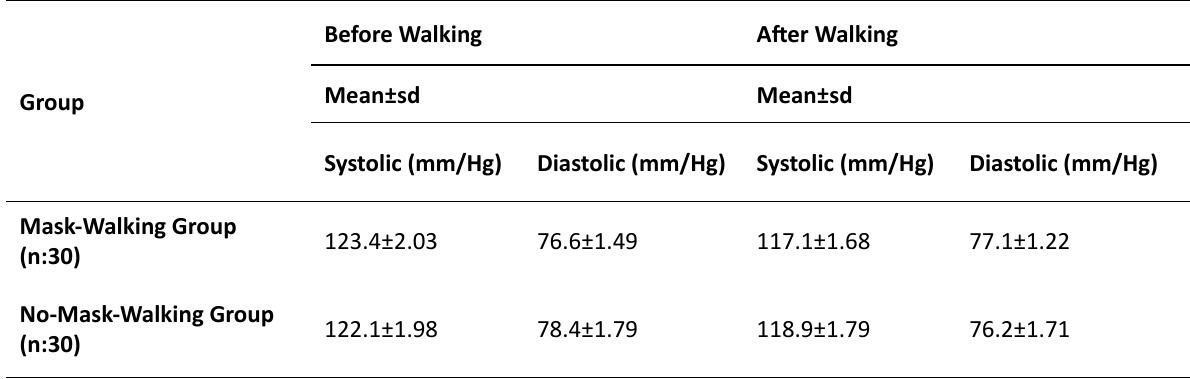
Table 1. The mean blood pressure values of all participants before and immediately after the walking